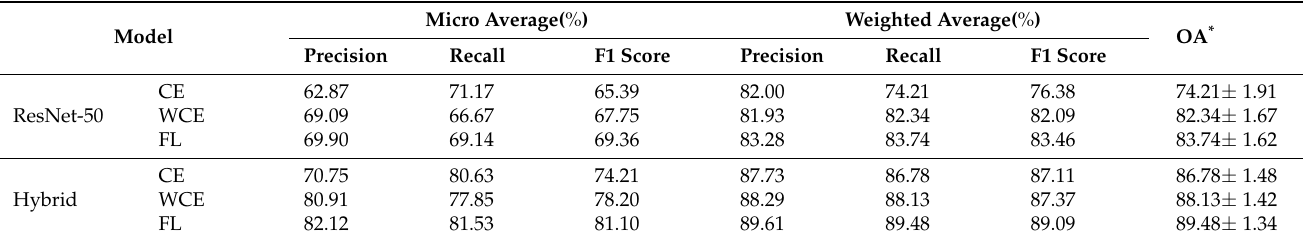
Table 2. Performance comparison of six proposed models on the International Skin Imaging Collabo- ration (ISIC) 2018 skin lesion classification dataset using different standard